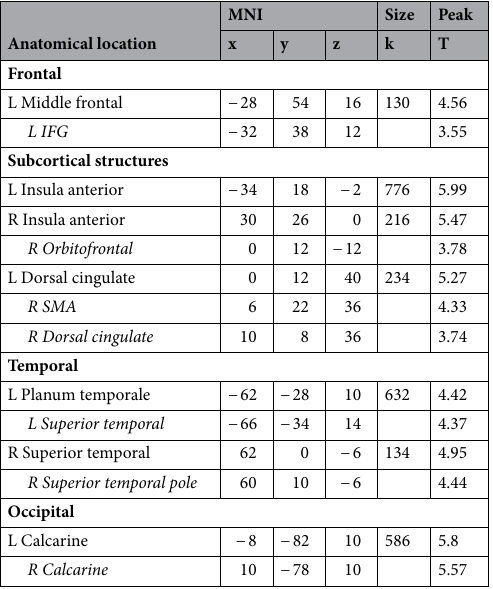
Table 2. Activation in children for the contrast words (positive, negative, neutral) compared to pseudowords (FWE corrected, p < 0.05, cluster level). x, y, z peak coordinates according to MNI stereotactic space, k cluster size in voxels, T -values for peaks, R right, L left, IFG inferior frontal gyrus, SMA supplementary motor area.